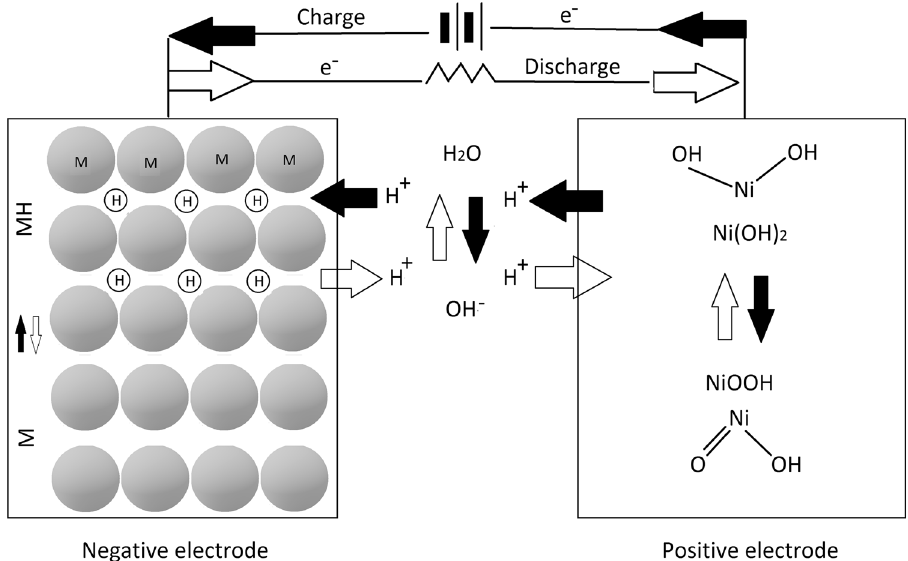
Fig. 1 Schematic diagram of the operation of a